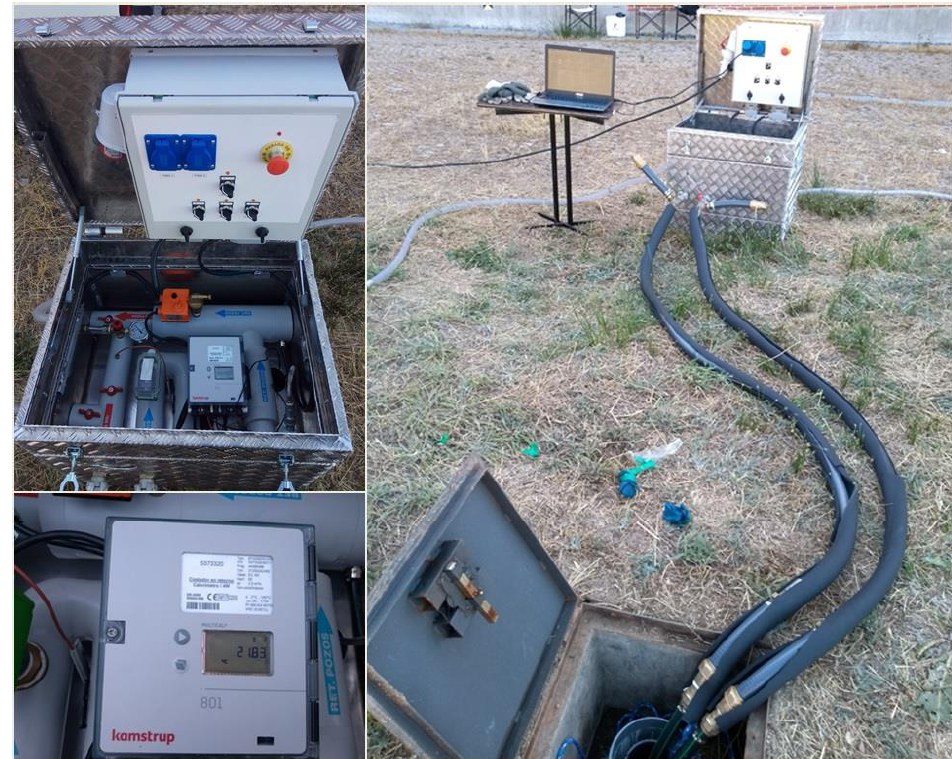
Figure 7. Thermal response test in the studied borehole. Left: TRT device and Kamstrup register; right: TRT connected to the borehole heat exchanger.